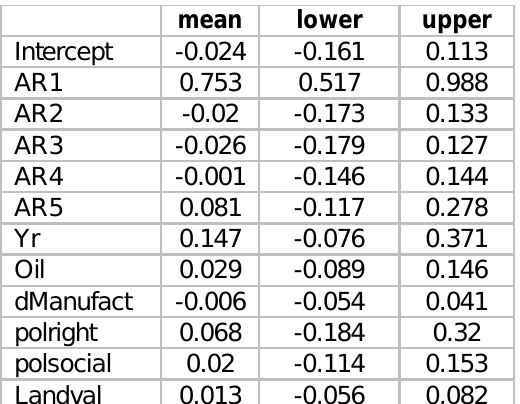
Table A1.6 . Average weighted parameter values for statistical models (mean and 95 % confidence intervals) for models for total subsidy level for 1914-1994.